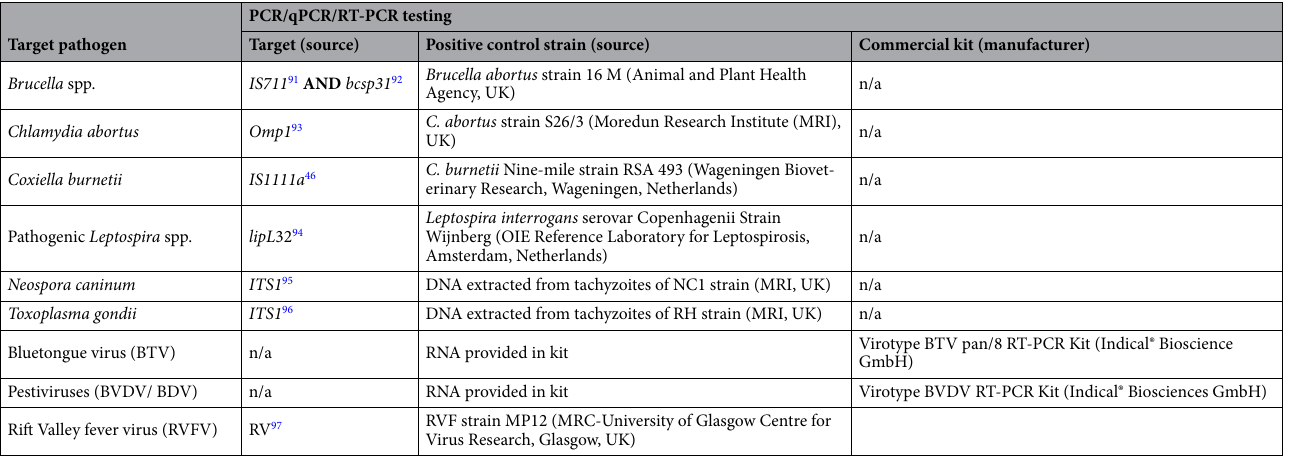
Table 4. Abortion cohort study molecular assays (PCR, qPCR and RT-qPCR) for cattle, goat and sheep samples for each target pathogen, northern Tanzania,